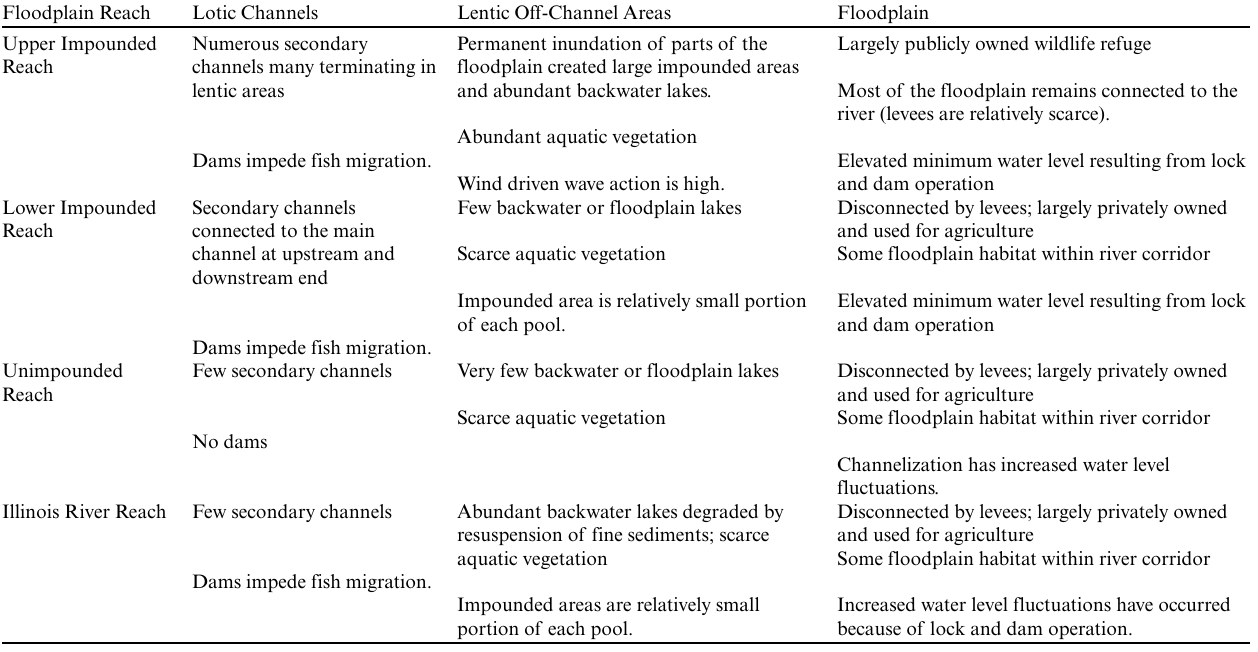
Table 1 . Summary of the modern characteristics of the four floodplain reaches of the Upper Mississippi River